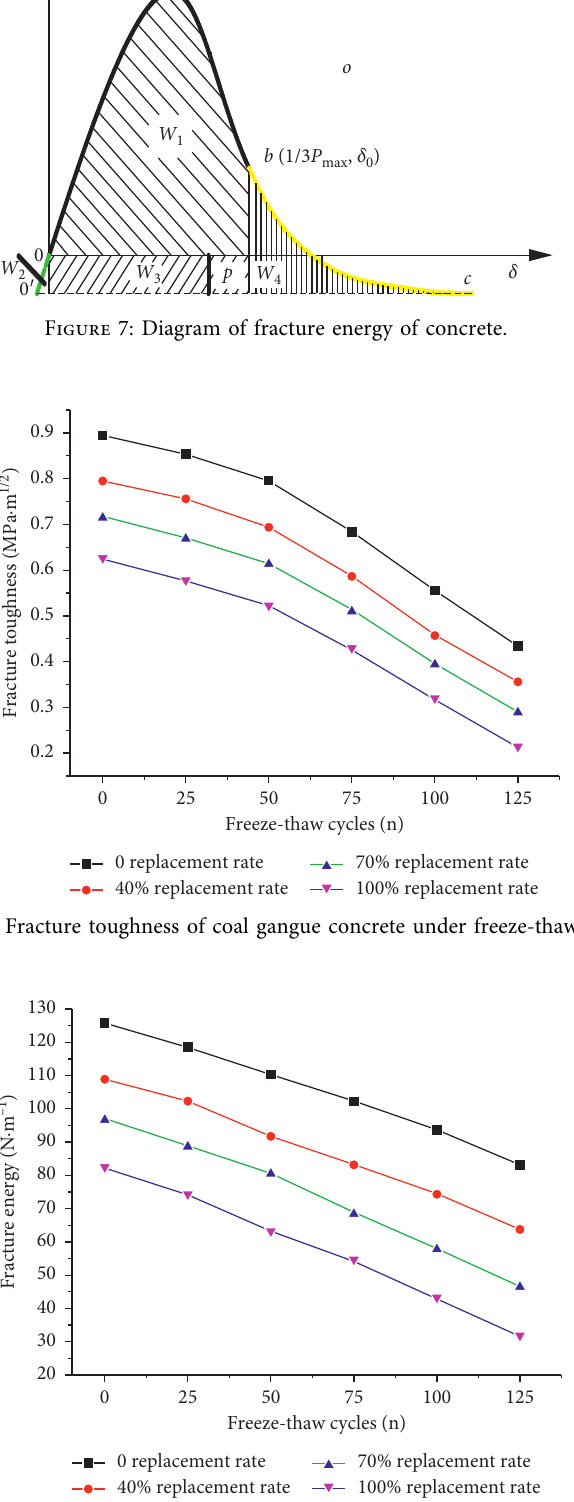
Figure 9: Fracture energy of coal gangue concrete under freeze-thaw